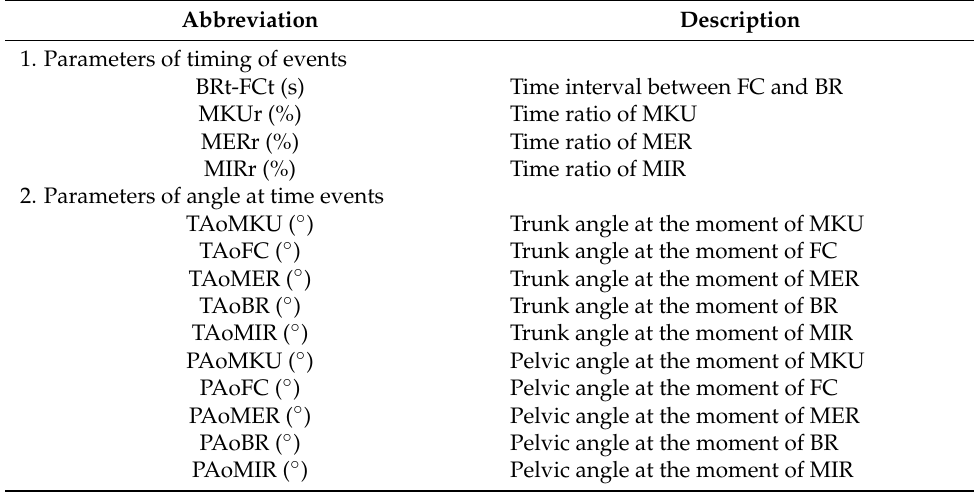
Table 2. Parameters derived from the kinematic data and their abbreviations.